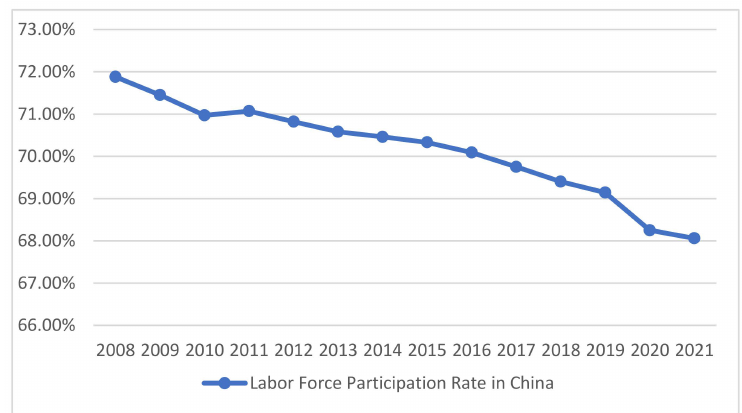
Figure 2. The labor force participation rate in China from 2008 to